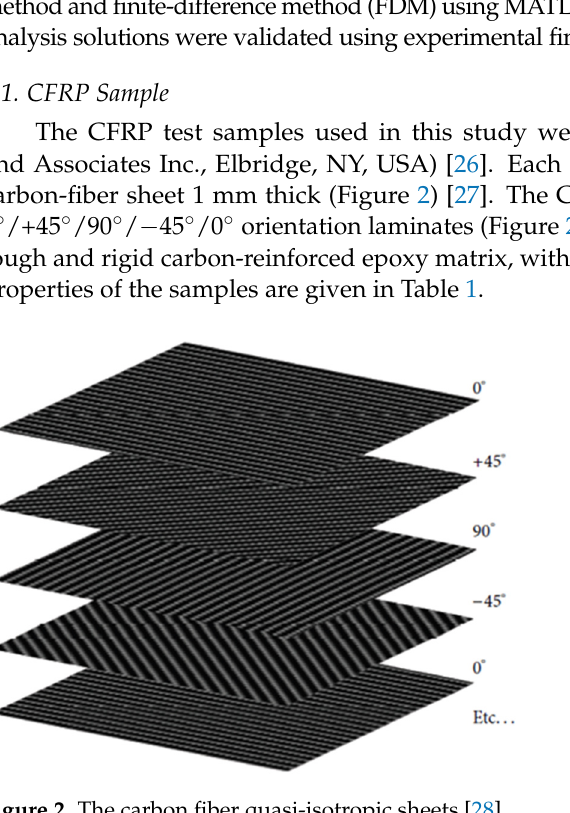
Figure 2. The carbon fiber quasi-isotropic sheets [28]. Table 1. Properties of the CFRP samples